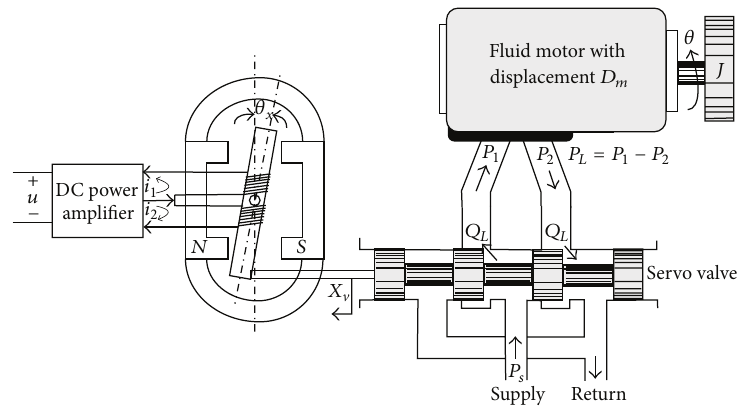
Figure 16: Block diagram of the electrohydraulic system.